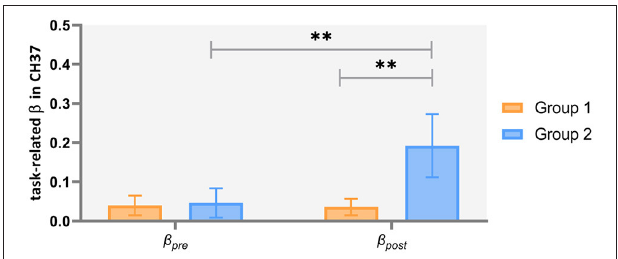
FIGURE 5 | Task-related brain activation in channel 37 in patients with mild to moderate depression (Group 1) and severe depression (Group 2). ** p <